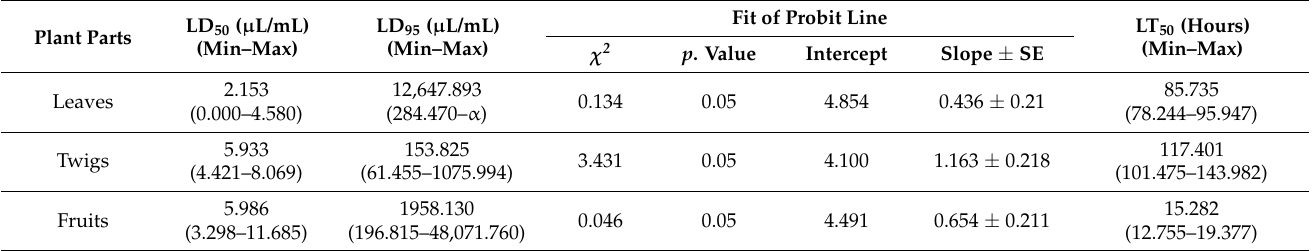
Table 4. The results of probit analysis for contact toxicity of Eucalyptus gunnii essential oils against Callosobruchus maculatus after 96 h exposure time.